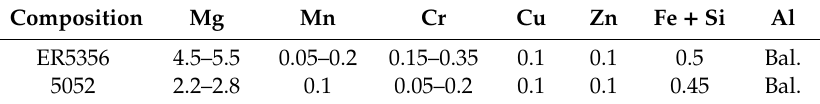
Figure 1. Wire Arc Additive Manufacturing (WAAM) deposition system: ( a ) schematic diagram, ( b ) physical diagram. Table 1. Chemical composition of ER5356 and 5052Al (wt. %).